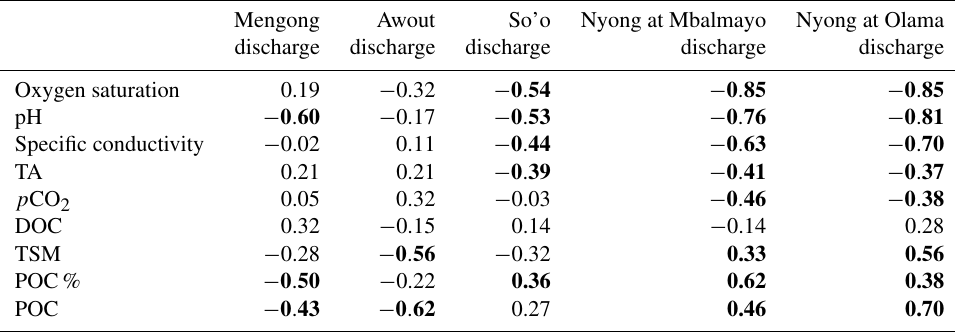
3.6 CO 2 degassing and C export to the ocean at the Nyong watershed scale Spatially, yearly averages of monthly k 600 increased